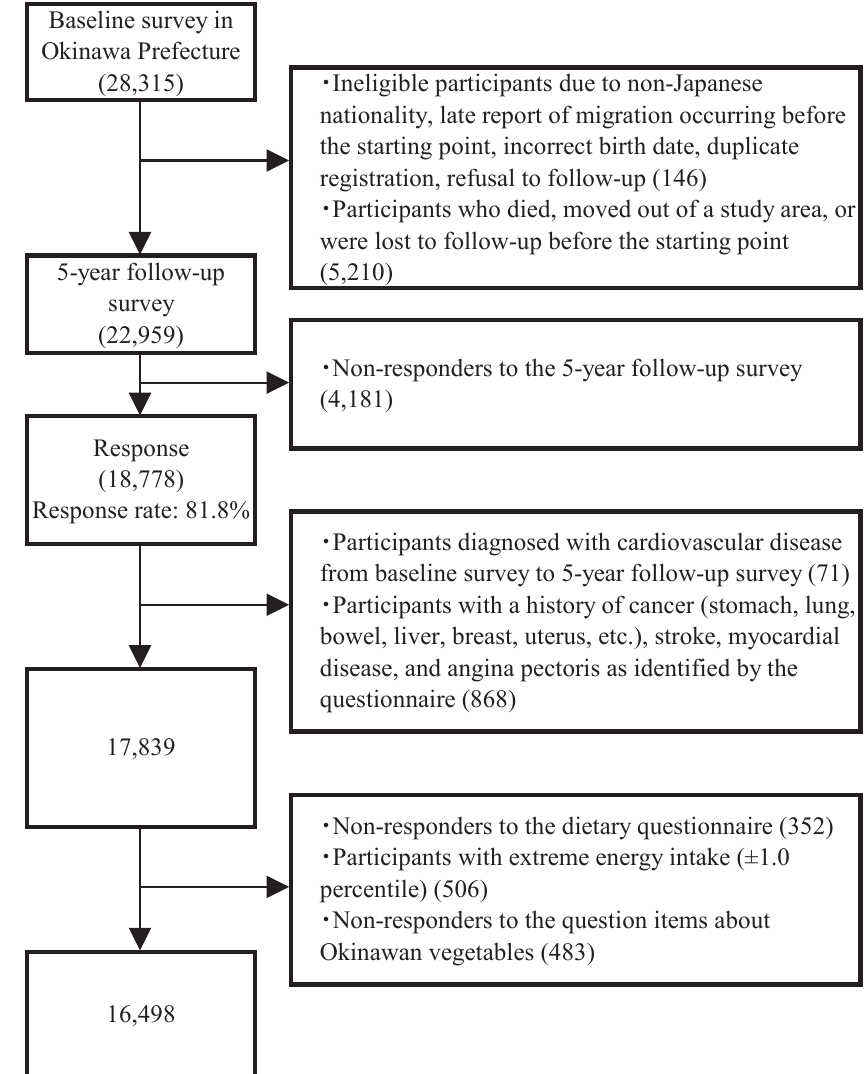
Figure 1. Flowchart of study participants in the Japan Public Health Center-Based Prospective Study on the association of total Okinawan vegetable consumption with incident stroke and coronary heart